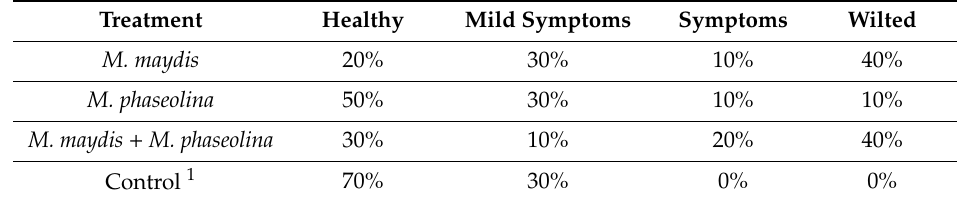
Table 6. Maize dehydration assessment at 82 DAS following infection with M. maydis and M. phaseolina (the 2018 experiment).